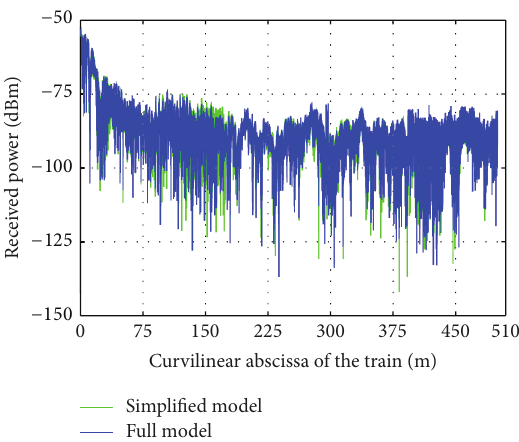
Figure 10: Evolution of the received power along the mobile train route according to the full and simplified